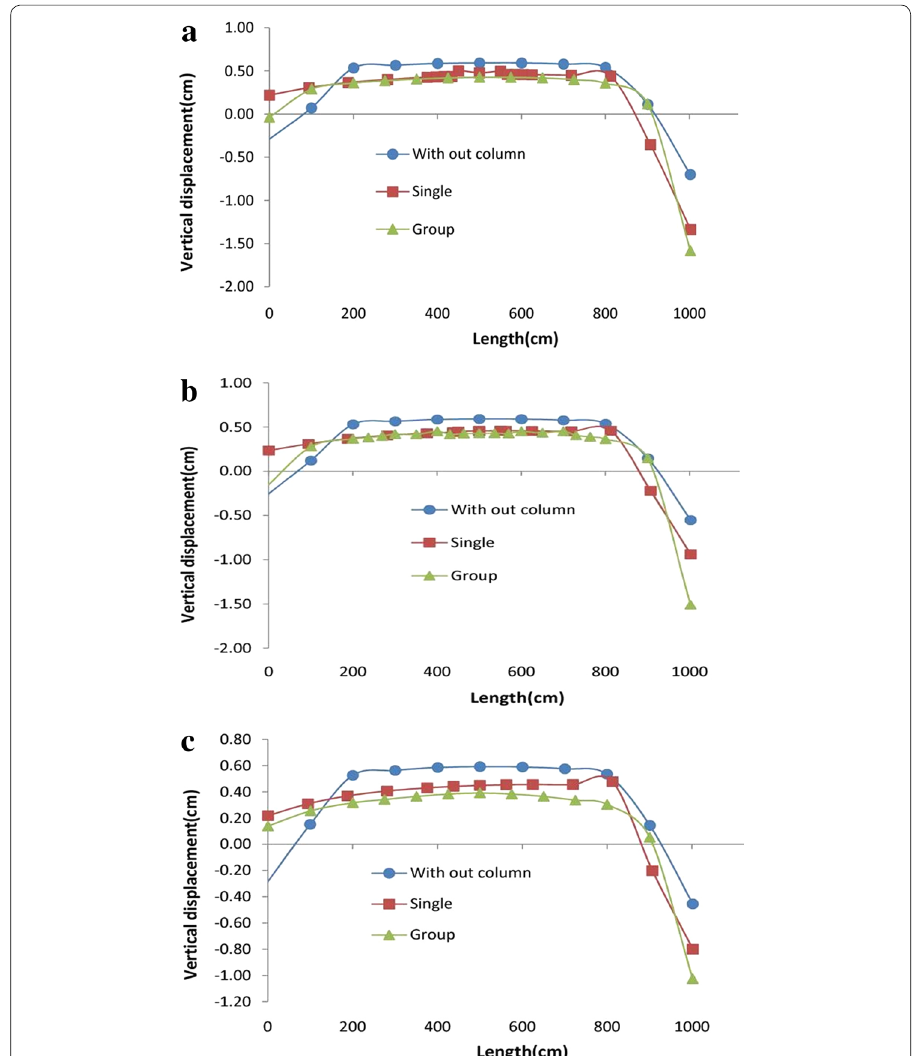
Fig. 18 Longitude profile of soil at ground surface, a at the center of the model, b 1 m far from model center, c 2 m from model